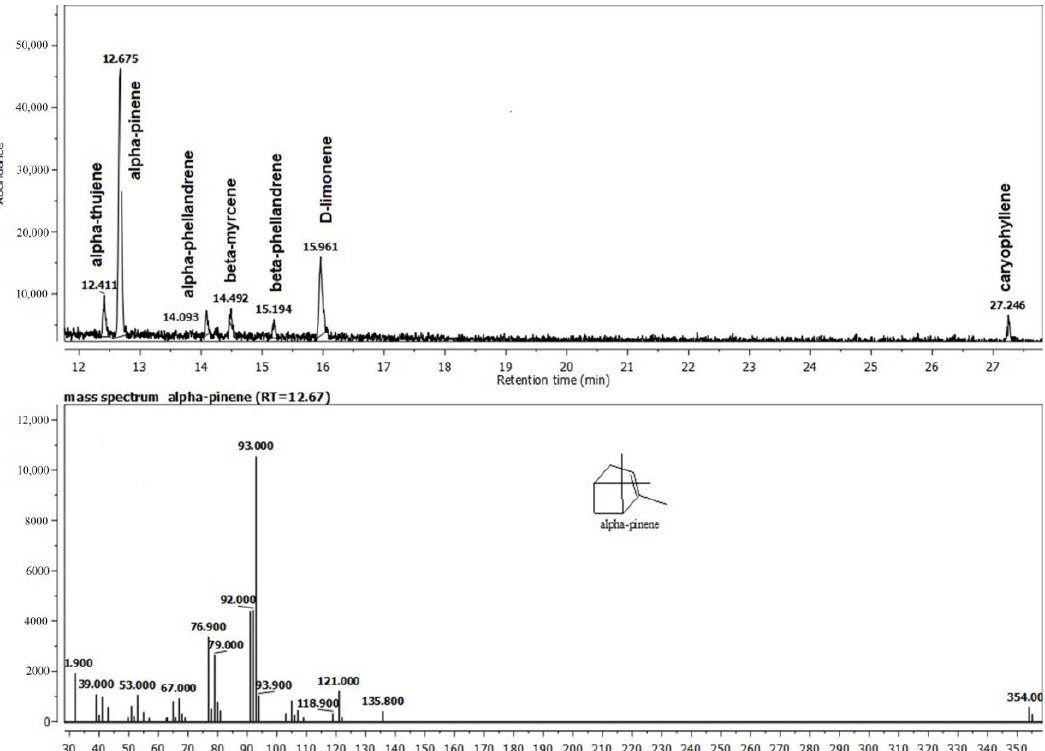
Figure 2. The composition of the Thieves ® oil (T) recovered from the gel G2T.